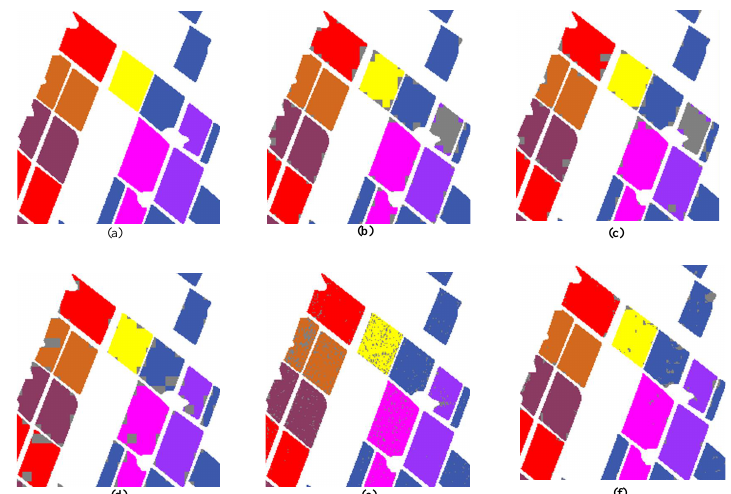
Figure 16. Visual display of methods on Flevoland1991.The enlarged images of the selected region. ( a ) GT. ( b ) RV-CNN. ( c ) CV-CNN. ( d ) LS-QCNN. ( e ) STS. ( f )